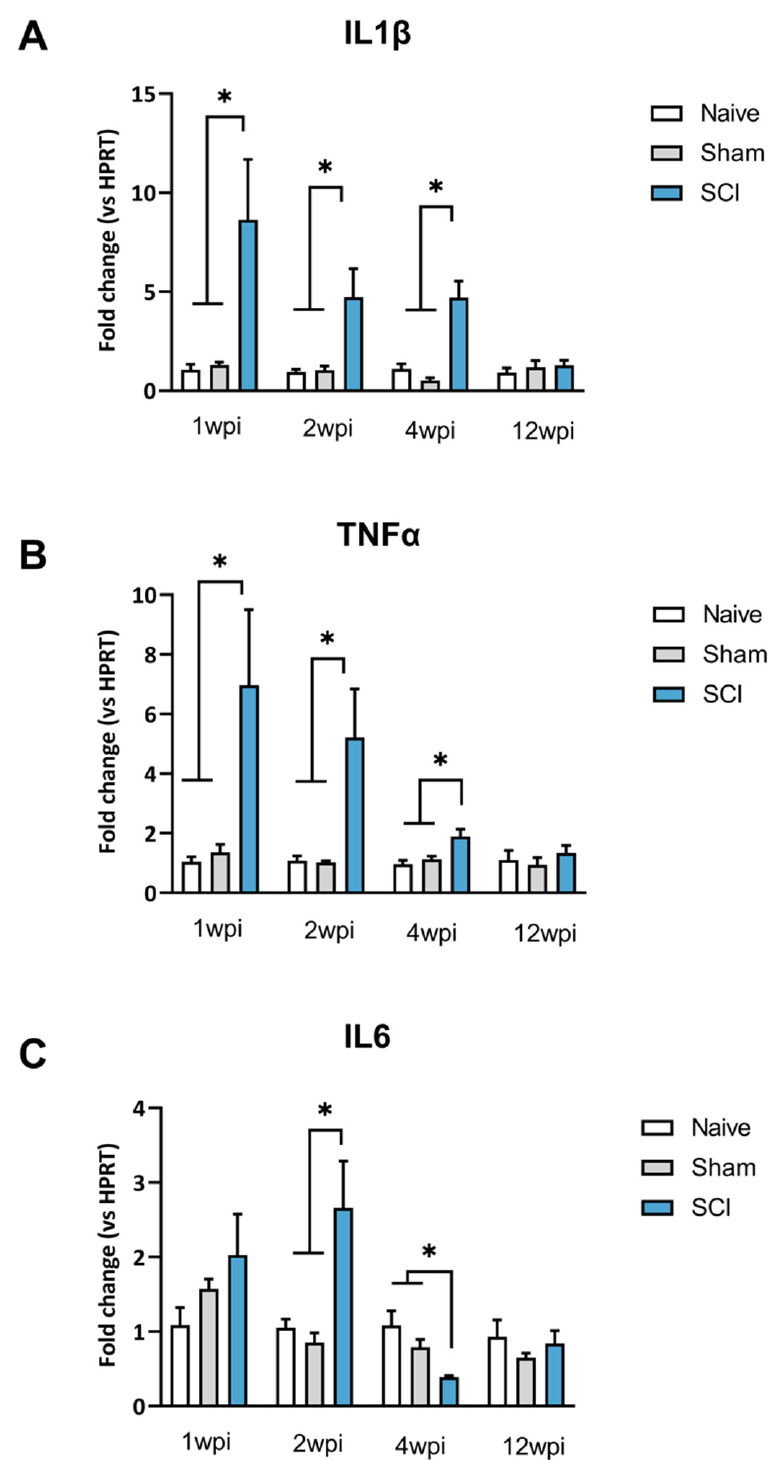
Figure 2. Spinal cytokine expression after mild spinal cord injury (SCI). IL1 β ( A ), TNF α ( B ), IL6 ( C ) showed expression changes compared to naïve and sham mice during the acute phase of SCI (1,2,4 wpi) in T8–T9 segments of the spinal cord. No expression changes were detected during the chronic phase of the SCI (12 wpi). Results are the mean ± SEM. Experimental groups: Naive (n = 4–6), Sham (n = 5–6) and SCI (n = 5–6). * p < 0.05 (one-way ANOVA followed by Tukey’s post-hoc test). IL1 β , Interleukin 1 β ; TNF α ; Tumor necrosis factor- α ; IL6, Interleukin-6; SCI, spinal cord injury; wpi, weeks post injury.